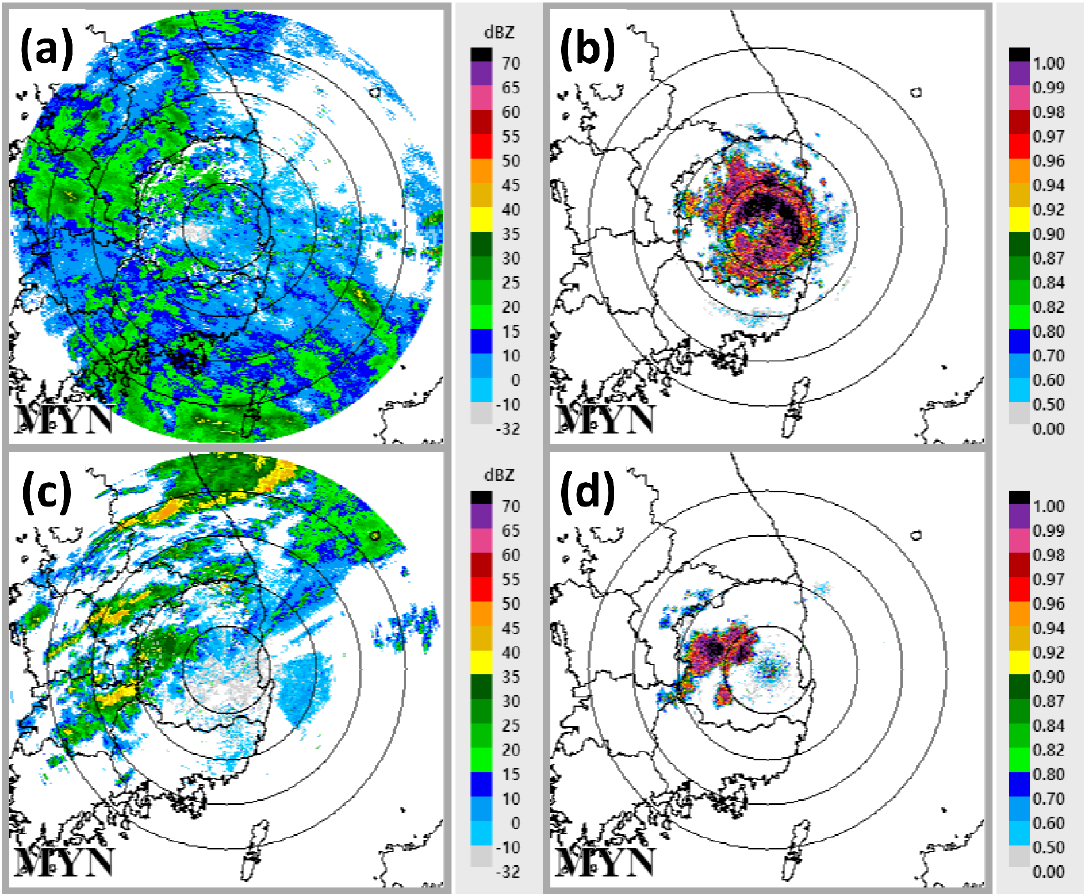
Figure 2. PPIs of ( a ) Z H for the elevation angle of 0.0 ◦ and ( b ) ρ HV for the elevation angle of 4.06 ◦ in the stratiform case. ( c ) and ( d ) are the same as ( a ) and ( b ) except for the convective case, respectively.